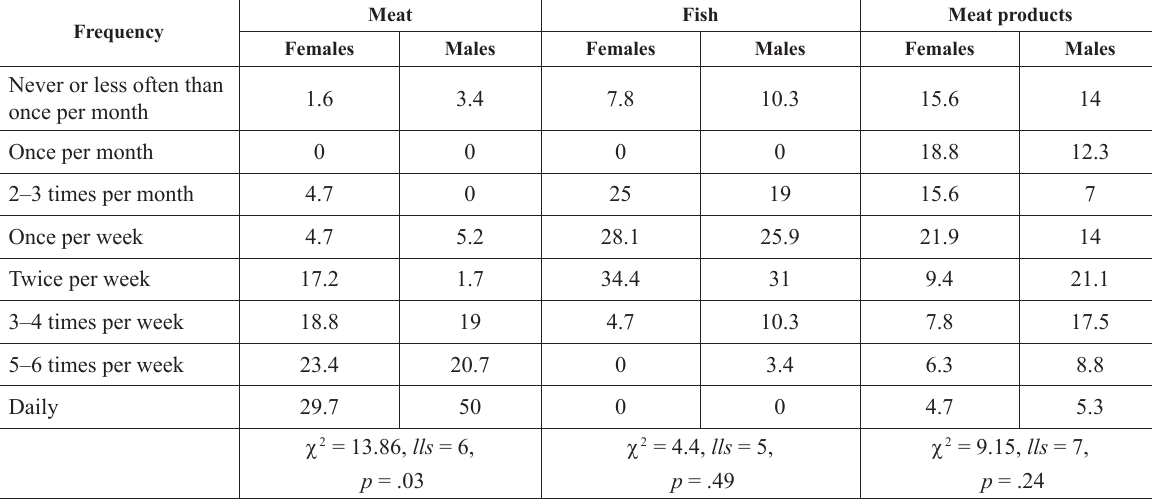
Table 1. Frequency of meat, meat products, and fish consumption according to gender Frequency